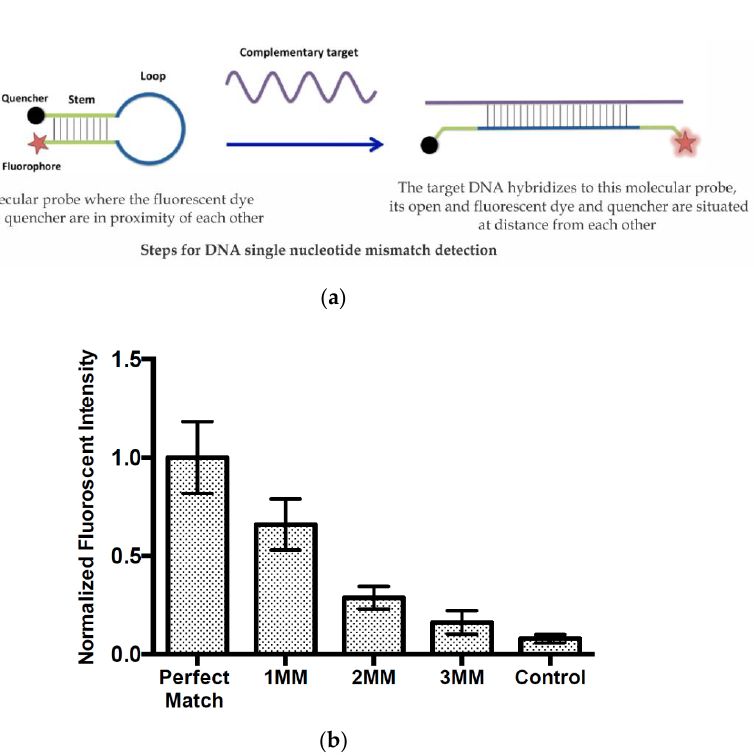
Figure 6. ( a ) The steps of the stretching process for the designed molecular probe during the process of DNA mismatch (MM) detection. ( b ) Normalized fluorescent intensity corresponding to perfect match, 1–3 mismatches and control. Table 1. DNA sequences used in the experiments.